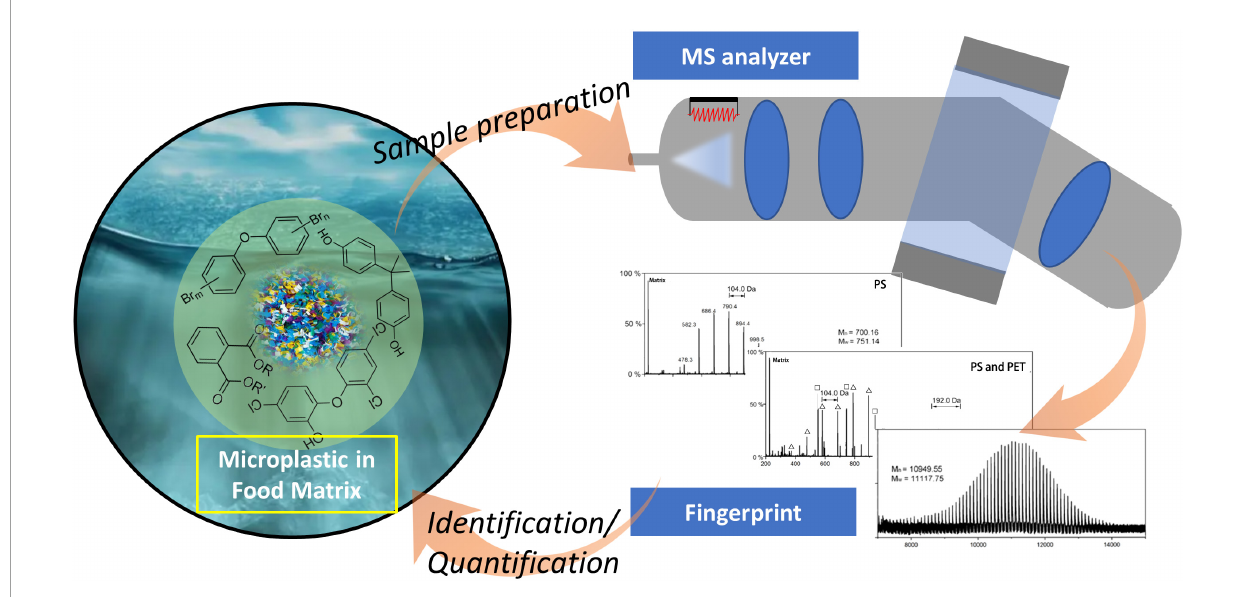
FIGURE1 Determination of microplastics by mass spectrometry in food